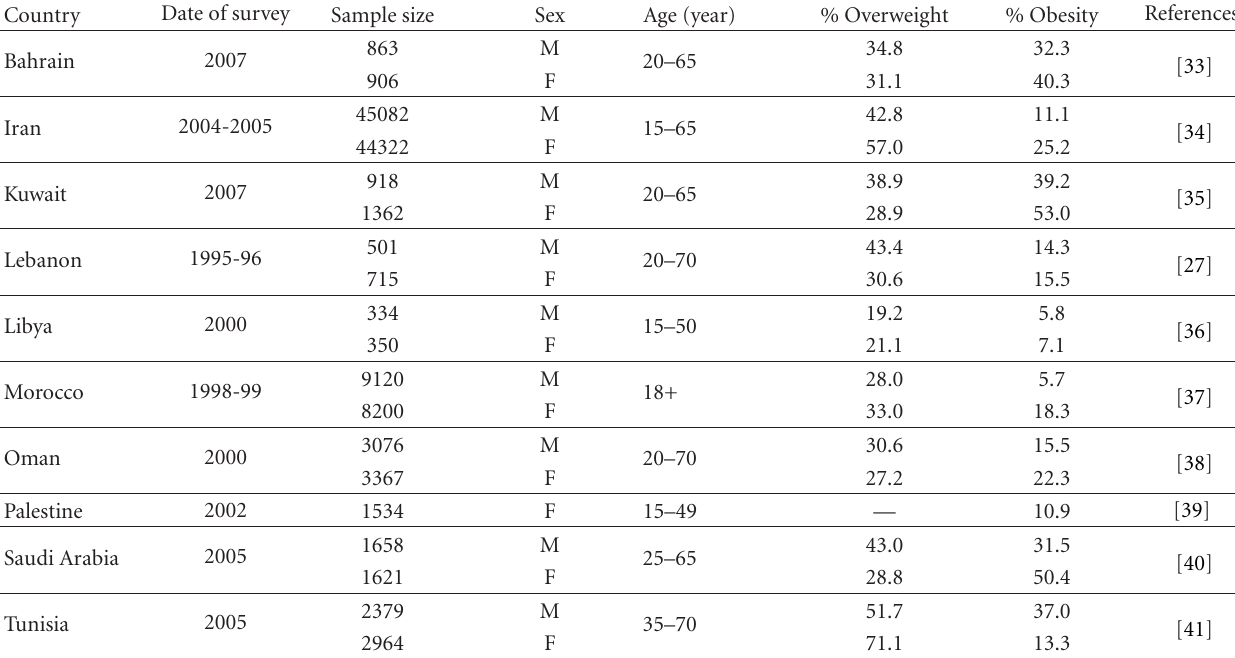
Table 3: National prevalence of overweight (BMI ≥ 25–29.9) and obesity (BMI ≥ 30) among adults in selected EMR countries.